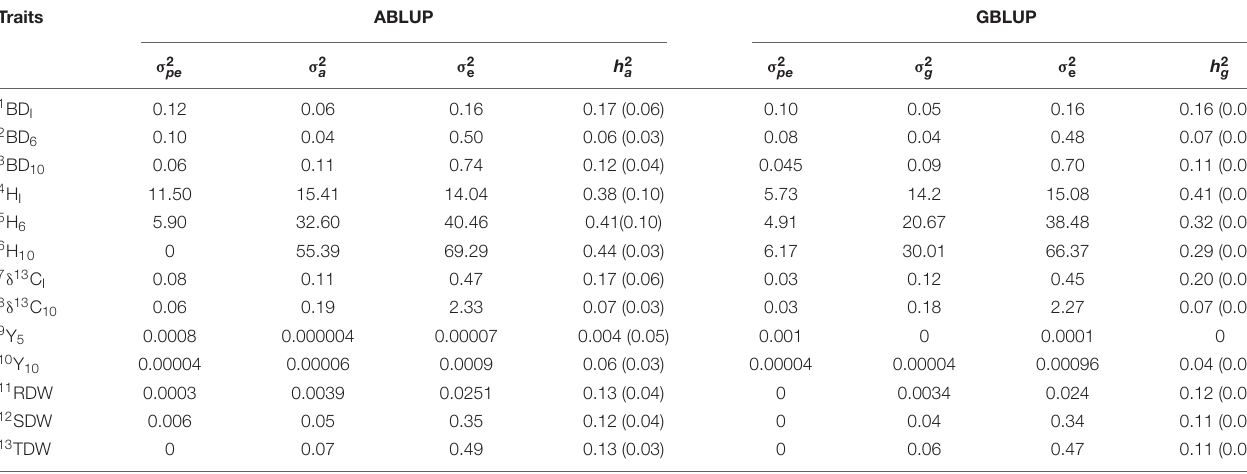
TABLE 2 | Estimates of variance components and heritability for growth traits, carbon isotope composition and chlorophyll fluorescence. Traits ABLUP GBLUP σ 2 σ 2 pe